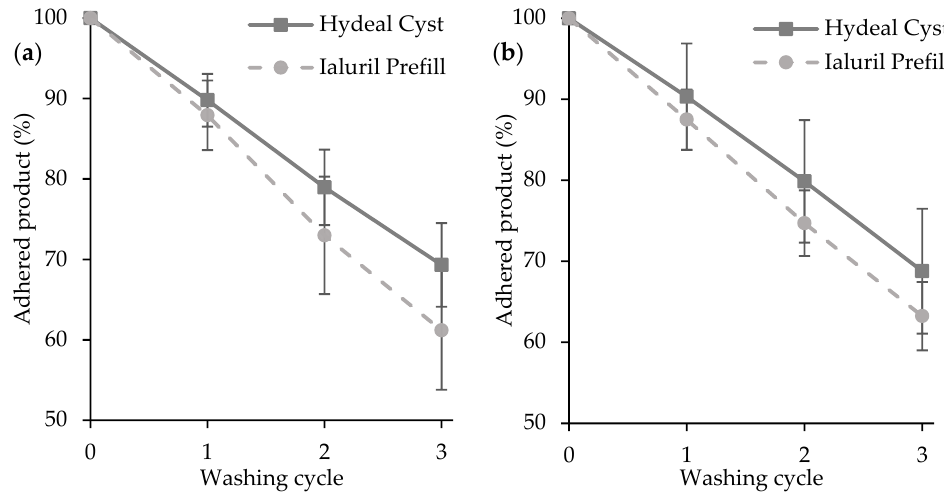
Figure 3. Percentage of the formulations still adhered to the bladder mucosa vs. washing cycle after 30 min ( a ) or 120 min ( b ) of contact (mean values ± sd; n = 6).